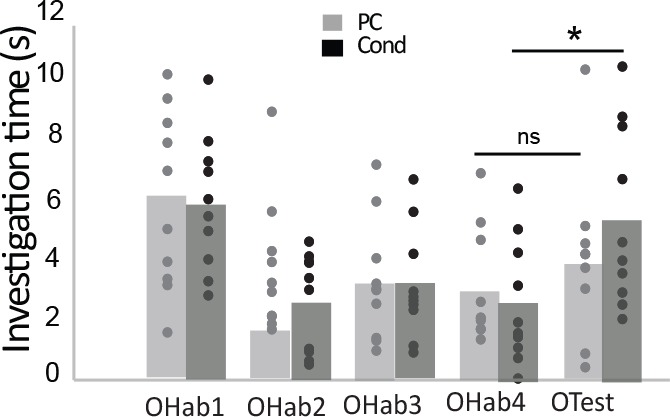
Improvement in discrimination after explicit learning.At the end of the associative learning, the habituation/cross habituation task indicated that +lim and -lim were not discriminated in the pseudo-conditioned (PC) group (n = 10; Friedman test for Habituation, p=0.02; Wilcoxon test for discri- mination p=0.44). In contrast, conditioning allowed discrimination as observed by the significant increase of investigation time between the last habituation trial (OHab4) and the presentation of the second odorant of the pair (Otest) (n = 10; Friedman test for Habituation, p=0.00073; Wilcoxon test for discrimination p=0.005).